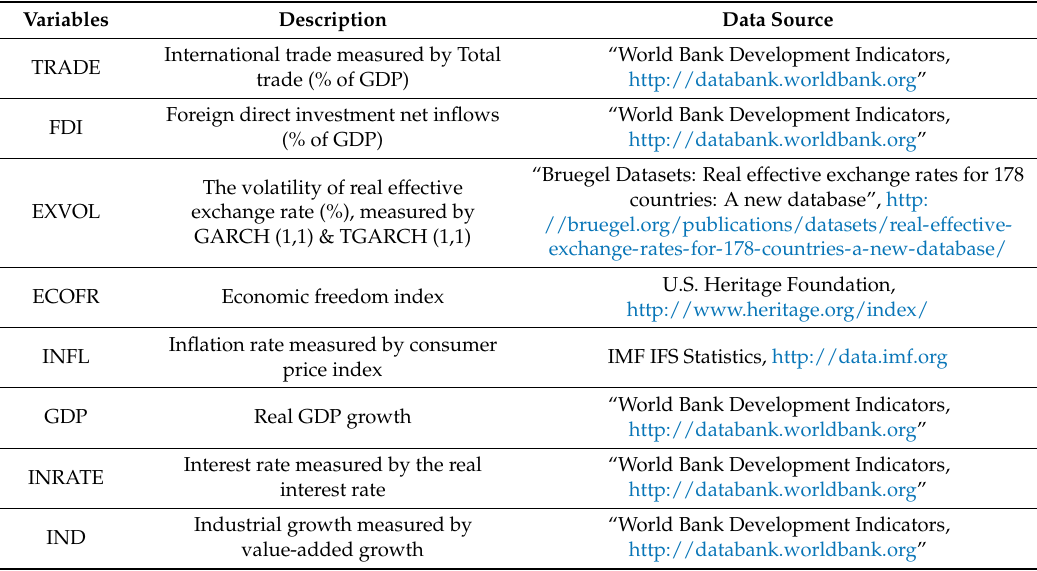
Table 1. Description of Variables and Sources of